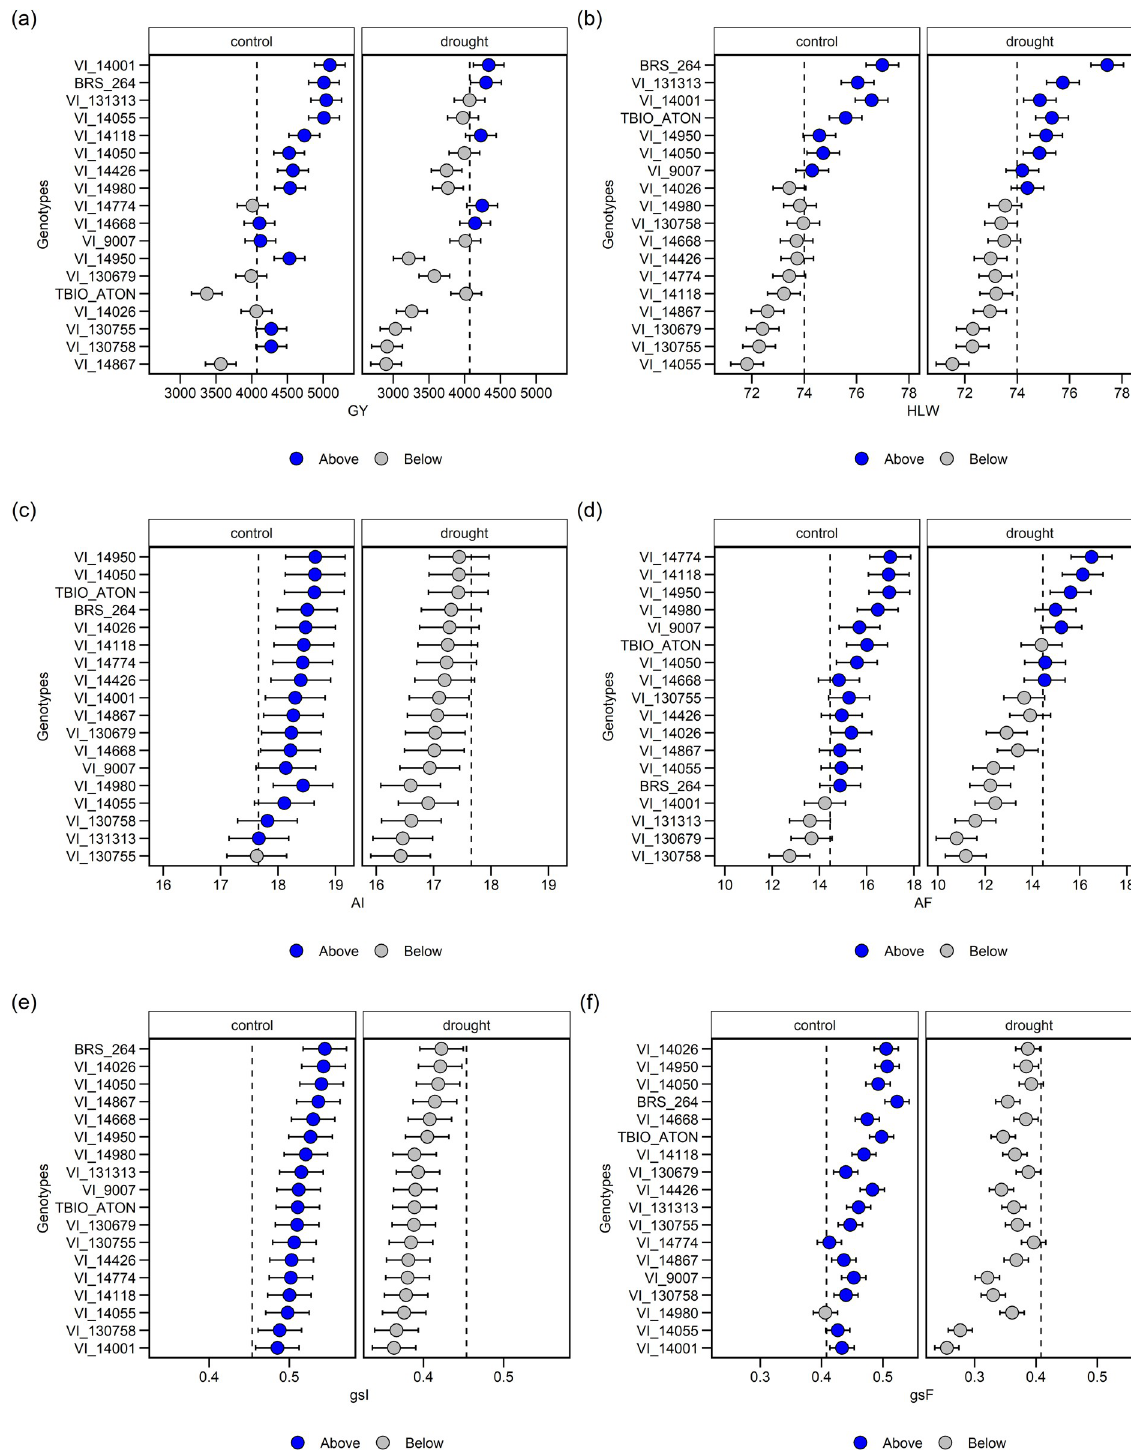
Fig 2. Results of BLUP values for 18 wheat genotypes evaluated under two conditions (control and stress) for variables grain yield (GY, kg ha - 1 ) (a), hectolitre weight (HLW, kg hL − 1 ) (b), rate photosynthetic liquid initial AI and final AF (AI and AF μ mol de CO stomachal conductance initial gsI and final gsF (gsi and gsF, mol H 2 O m -2 s -1 ) (e and f).